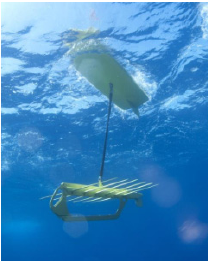
Figure 1. A type of wave glider manufactured by Liquid Robotics Inc.